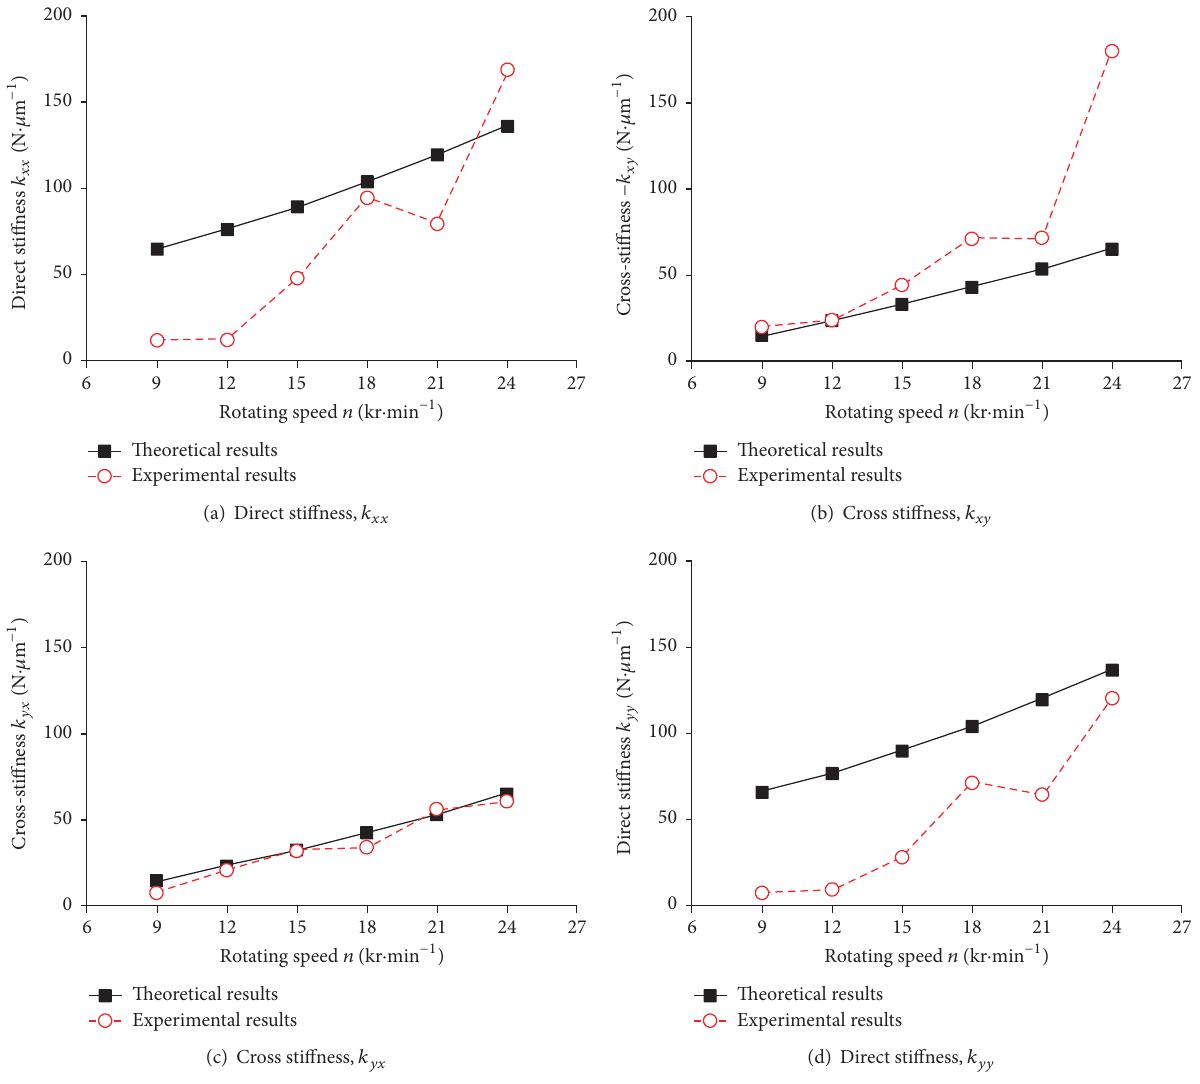
Figure 6: Comparative results of the stiffness coefficients by additional unbalance excitation: one water supply pressure (2.5MPa) and six journal rotating speeds (9,000 r/min to 24,000